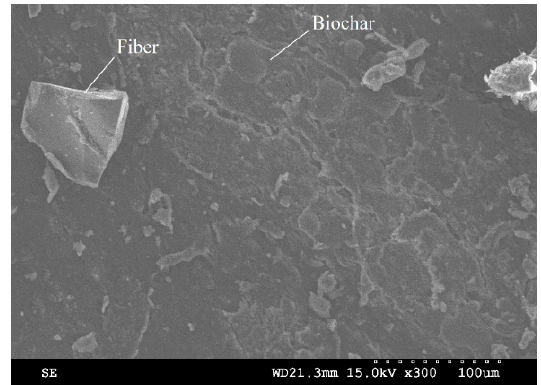
( a ) SEM image of material before machining.